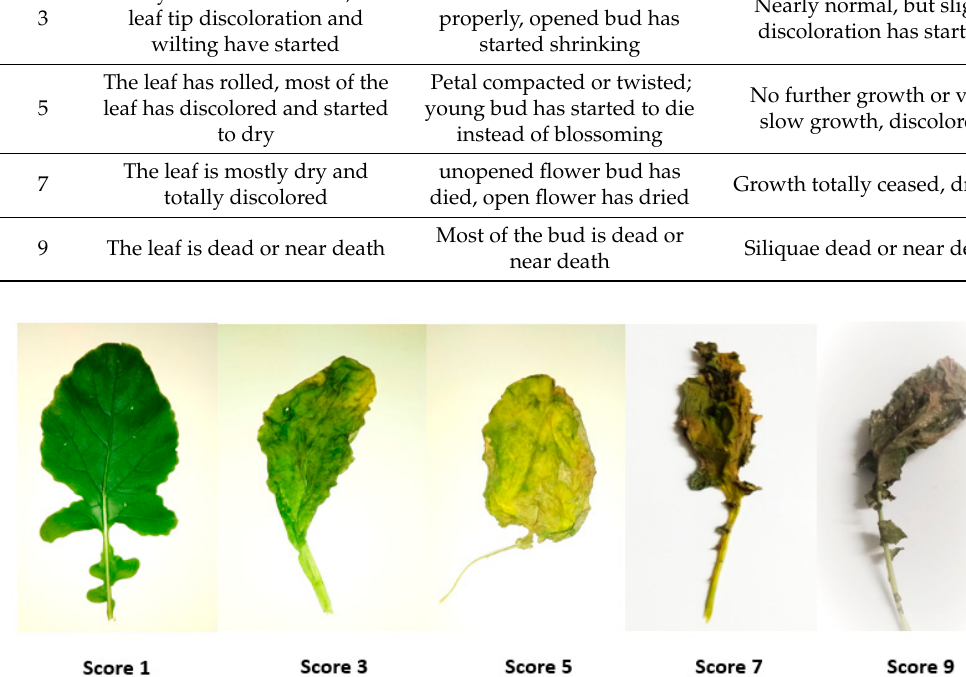
Figure 2. Leaf injury scoring for salinity stress.